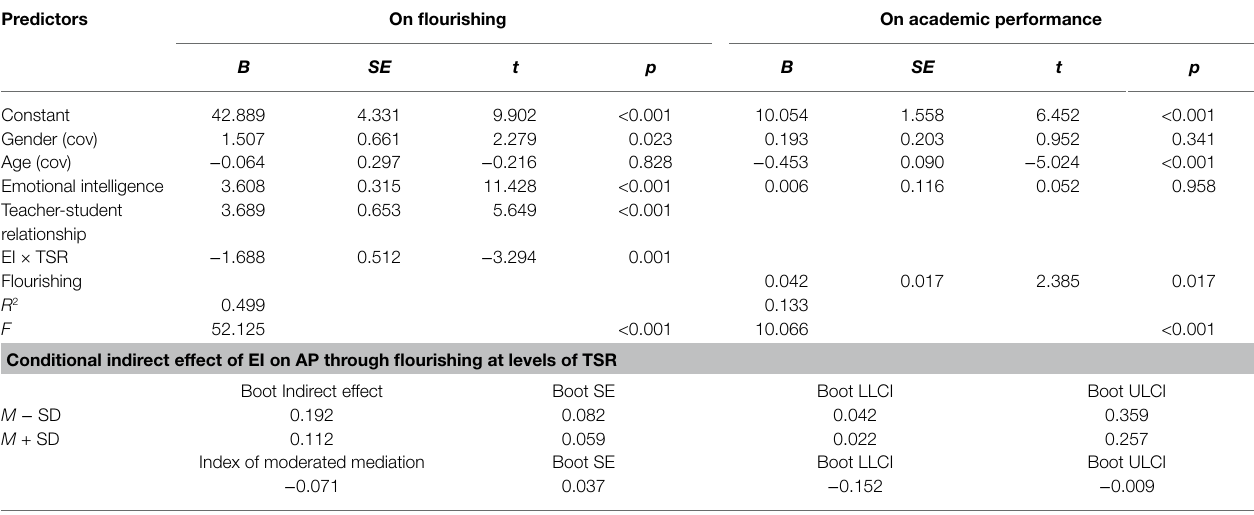
TABLE 3 | The indirect effect of emotional intelligence on academic performance through flourishing conditioned by teacher-student relationship quality. Predictors On flourishing On academic